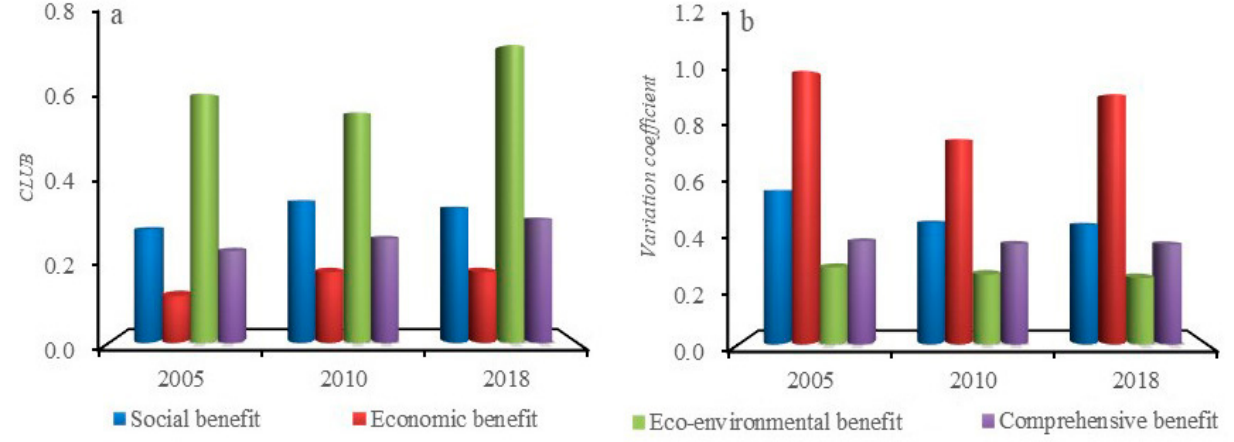
Figure 4. CLUB value and its variation coefficient. ( a ) Construction land use benefit level, ( b ) Variation coefficient of construction land use benefit.